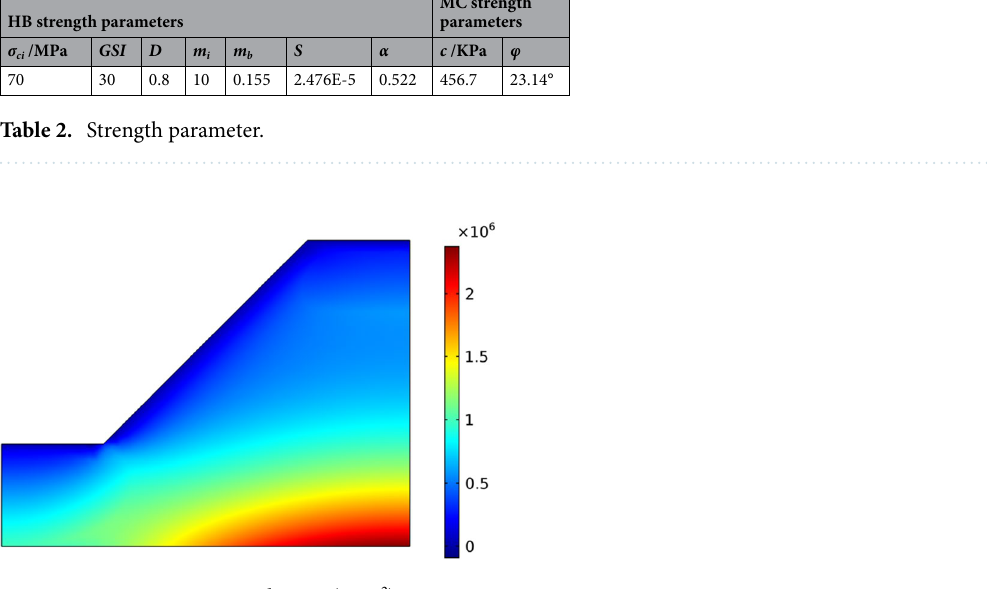
Figure 7. Minimum principal stress (N/m 2